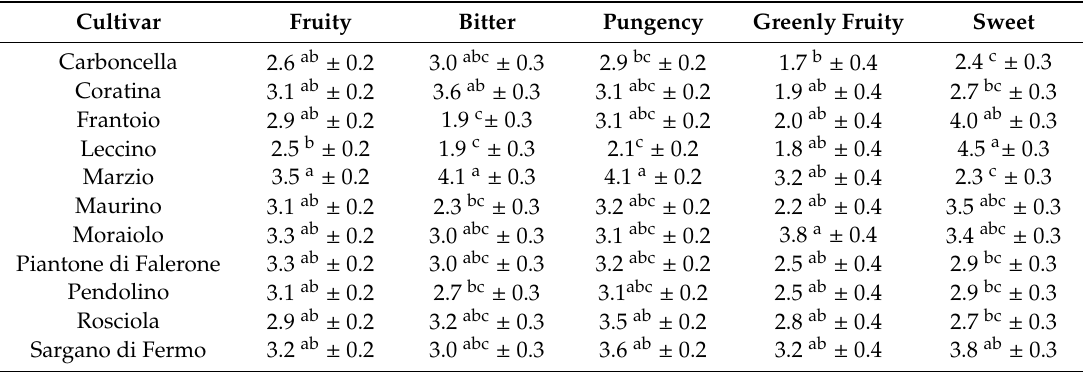
Table 2. Sensory evaluation and perceived intensity (expressed as means of ratings given by assessors ± standard error of the means) of the main sensory attributes in the investigated monovarietal